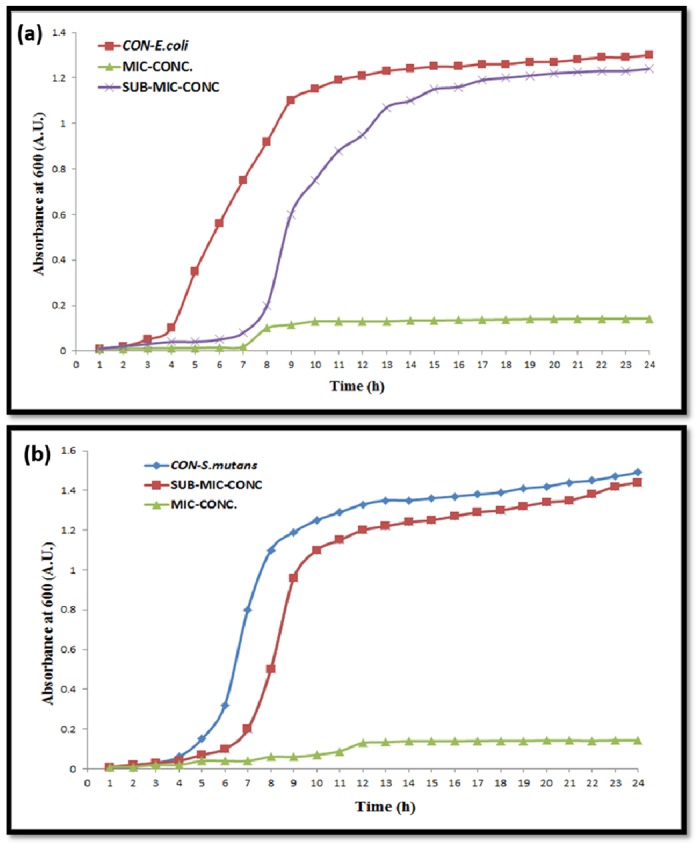
Growth curves of bacteria under the influence of AgNPs.(a) E. coli (b) S. mutans.